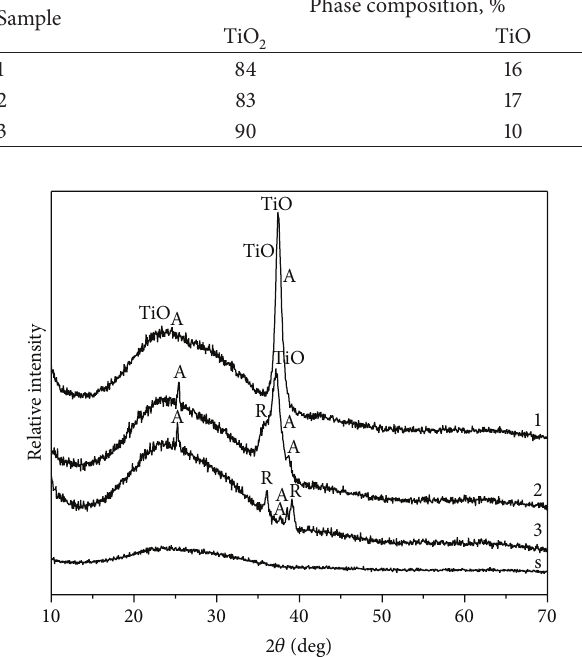
Figure 1: XRD patterns for Ti 𝑥 O 𝑦 films obtained by DC